Question: Which kind of chart has been used to present this data?
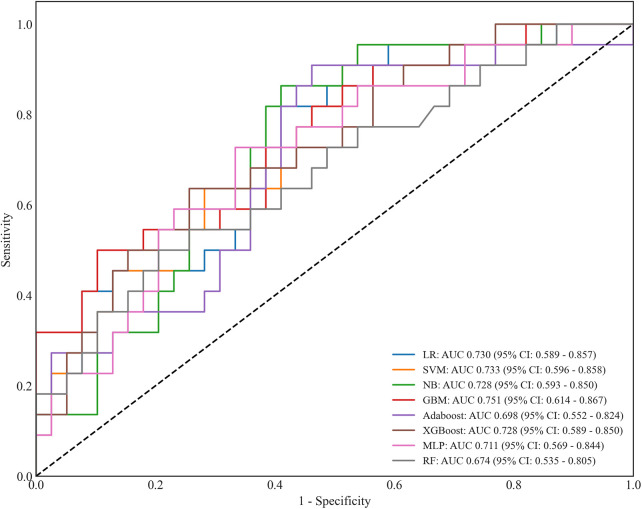
Answer: line